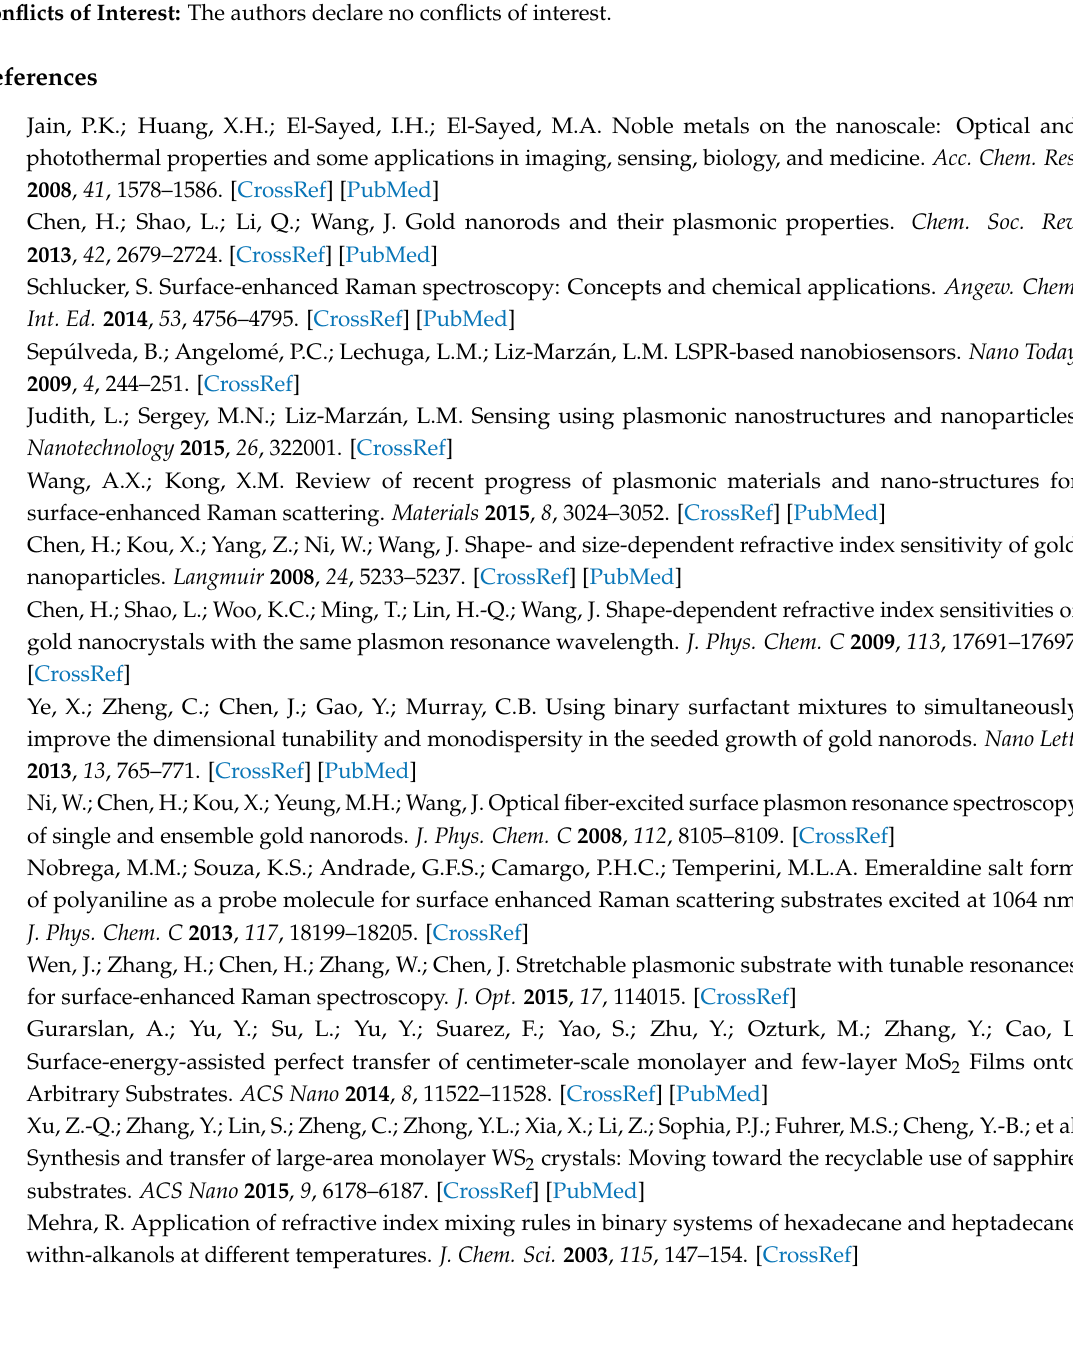
s1, Figure S1: Schematic showing the procedures of growing the gold nanorods with large aspect ratios; Figure S2: Dependence of the refractive index on the mass ratio of glycerol in water–glycerol mixture; Figure S3: AFM image of the SERS substrate; Figure S4: Schematics showing the fabrication of the flexible SERS substrate; Figure S5: Extinction spectra of aqueous gold nanorods sample, gold nanorods deposited onto glass substrate, and the flexible SERS